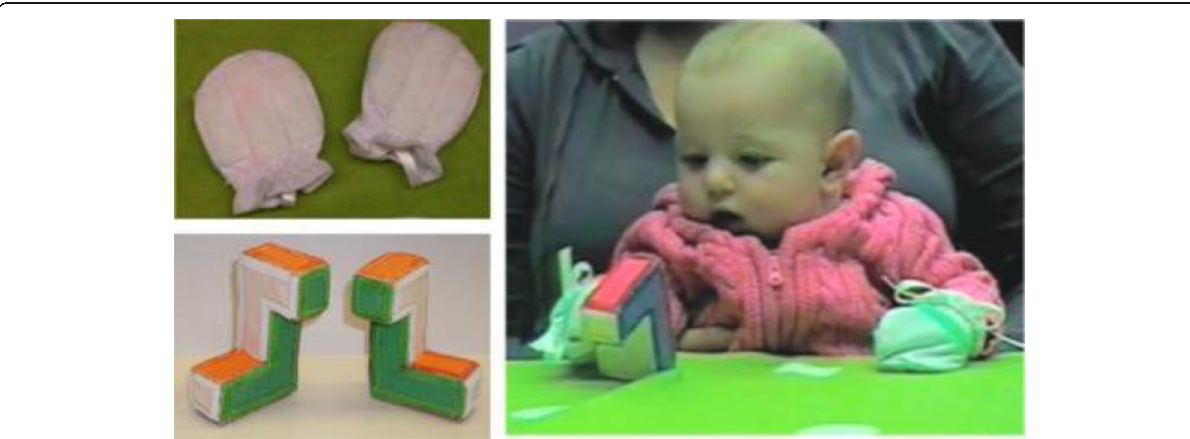
Fig. 4 Photographs illustrating Slone et al. ’ s (2018) object exploration task. Top left: Velcro mittens worn by infants in the task. Bottom left: Objects given to the infants during the task. Right: An infant engaged in the object exploration task. (The parent of this infant provided written informed consent to publish this image). Reproduced from Slone et al. (2018), Fig.